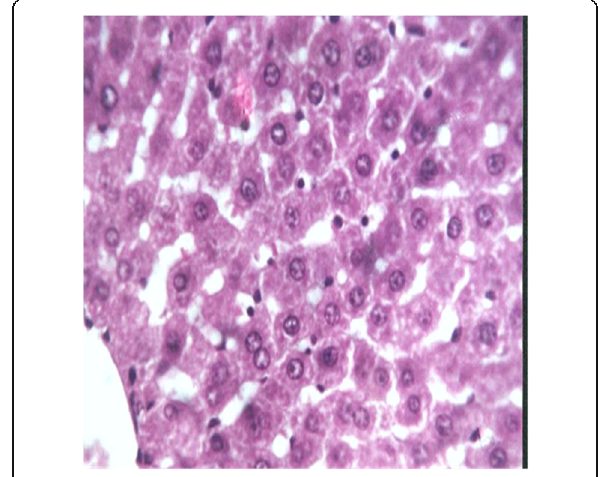
Fig. 5 Photomicrograph of CCl4-treated liver sections showing dense amorphous eosinophilic material between and around hepatocytes and vacuolar degeneration (H&E; ×400)